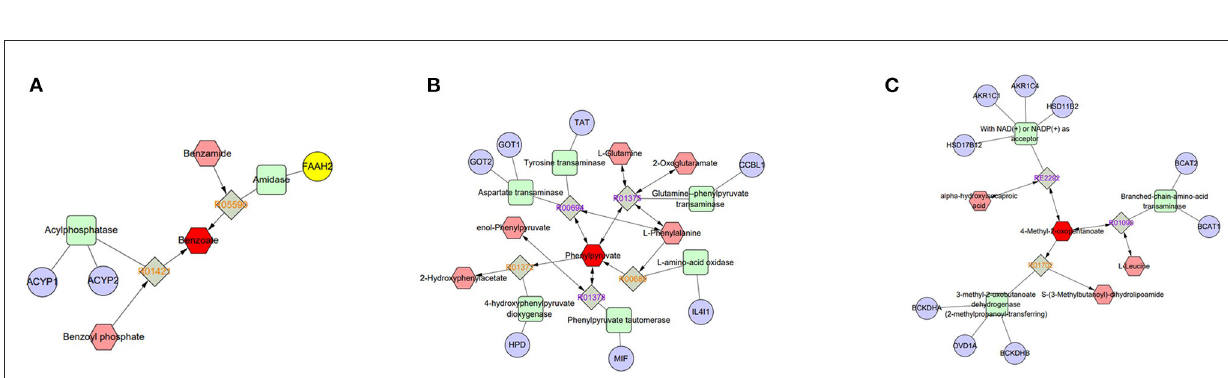
FIGURE7 Compound-reaction-enzyme-gene networks of important differential metabolite biomarkers de-termined using Metscape. (A) Benzoic acid, (B) phenylpyruvate, and (C) 4-methyl-2-oxopentanoate (ketoisocaproic acid). The metabolites are shown in red hexagons. Gray squares: reaction nodes with reaction ID; pale red hexagons: compound nodes; green squares: enzyme nodes; blue circles: gene nodes.